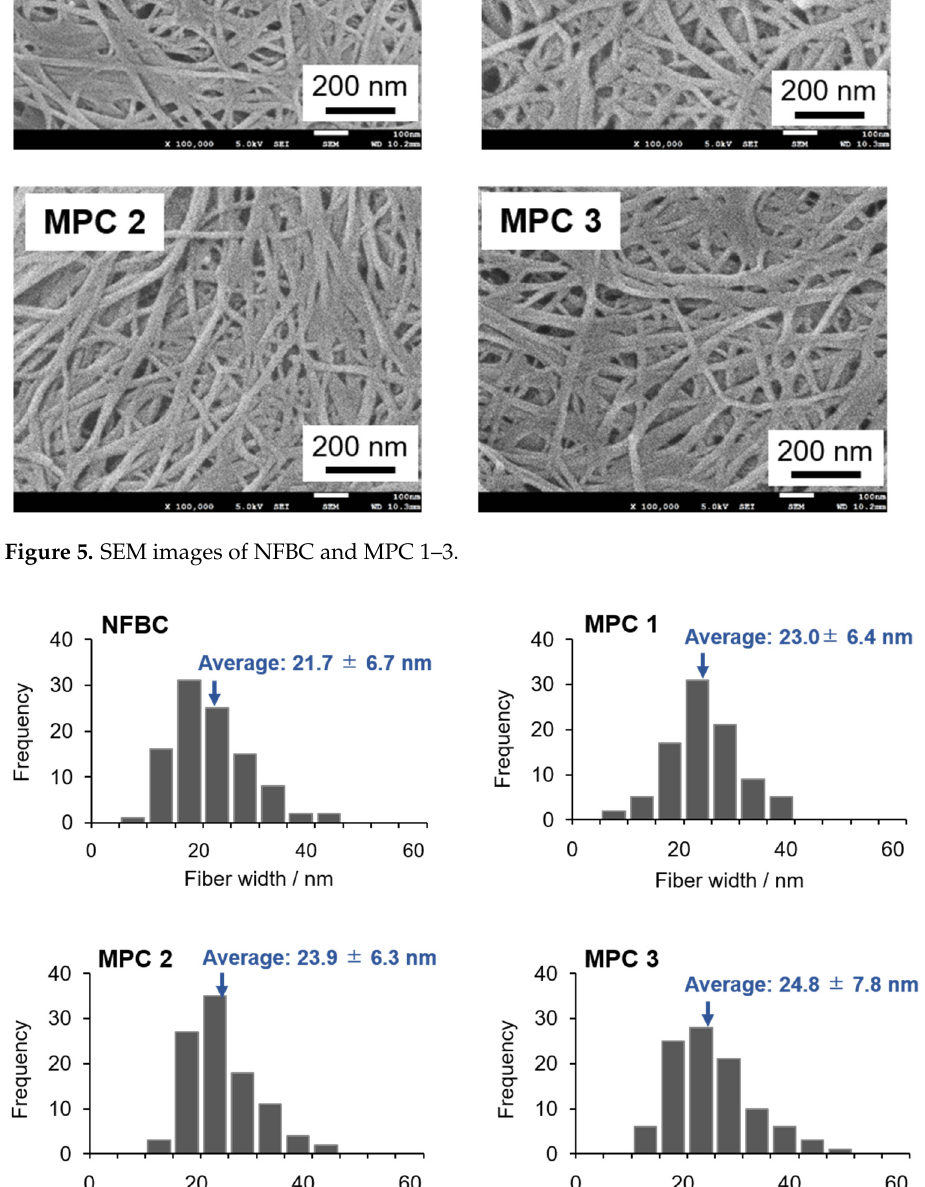
Figure 6. Fiber-width distributions ( n = 100) of NFBC and MPC 1–3 determined from the scanning Figure 6. Fiber ‐ width distributions ( n = 100) of NFBC and MPC 1 ‒ 3 determined from the scanning electron microscopy (SEM) images in Figure electron microscopy (SEM) images in Figure 5.